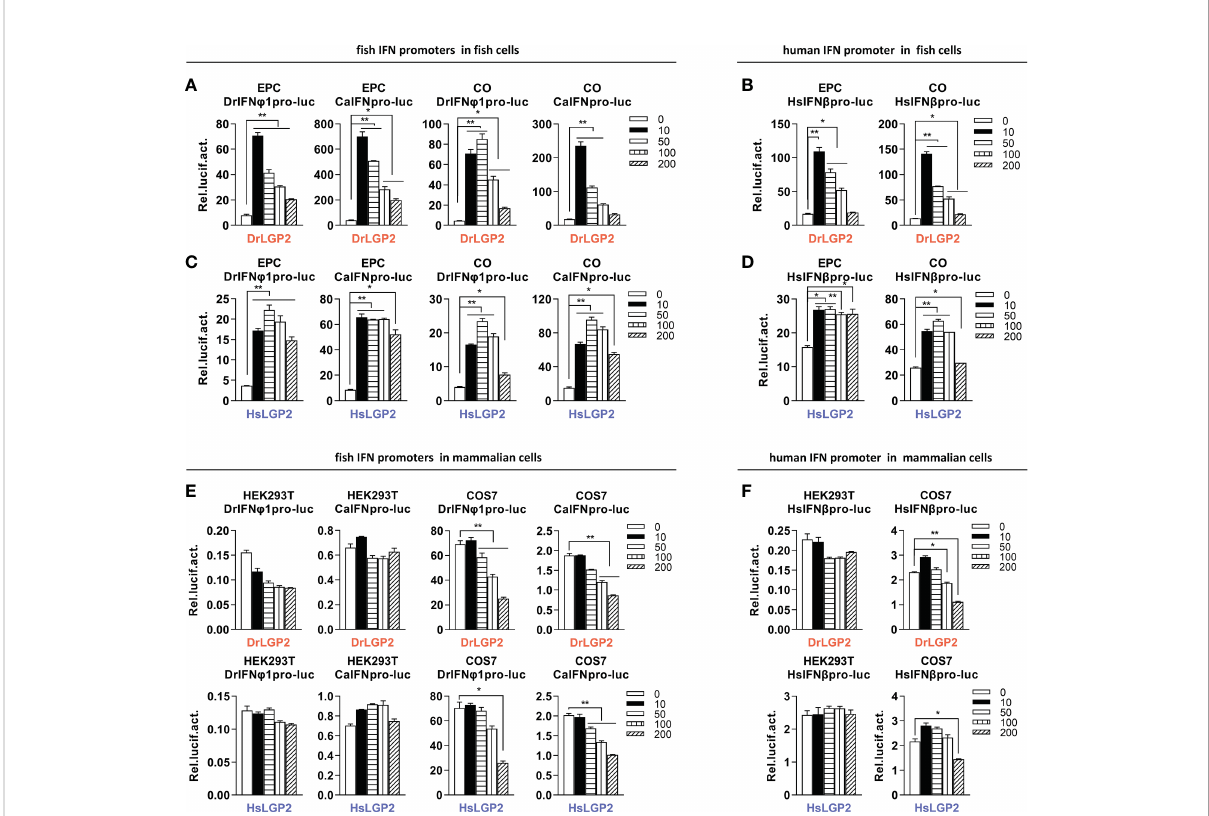
FIGURE 1 Overexpression of zebra fi sh or human LGP2 facilitates the activation of fi sh and human promoters in fi sh cells but not in mammalian cells (A – D) DrLGP2 and HsLGP2 both activated fi sh IFN promoters (A, C) and human IFN b promoter (B, D) in fi sh cells. EPC cells and CO cells seeded overnight in 24-wells plates were co-transfected with DrIFN j 1pro-luc or CaIFNpro-luc (A, C) , or HsIFN b pro-luc (200 ng) (B, D) , together with DrLGP2 (A, B) or HsLGP2 (C, D) at increasing doses (0, 10, 50, 100, 200 ng). pRL-TK (20 ng) was transfected as internal control. 48 h later, cells were collected for luciferase assays. (E, F) DrLGP2 and HsLGP2 did not activate fi sh IFN promoters (E) and human IFN b promoter (F) in mammalian cells. HEK293T cells and COS7 cells seeded overnight in 24-wells plates were co-transfected with DrIFN j 1pro-luc or CaIFNpro-luc (E) , or HsIFN b pro-luc (200 ng) (F) , together with DrLGP2 or HsLGP2 at increasing doses (0, 10, 50, 100, 200 ng). Renilla vector (pRL-TK, 0.2 ng) was transfected as internal control. 48 h later, cells were collected for luciferase assays. Error bars show the SDs of triplicate transfections. Data were shown as mean ± SD (N=3). P values were calculated using ANOVA. ** P < 0.01, * P <